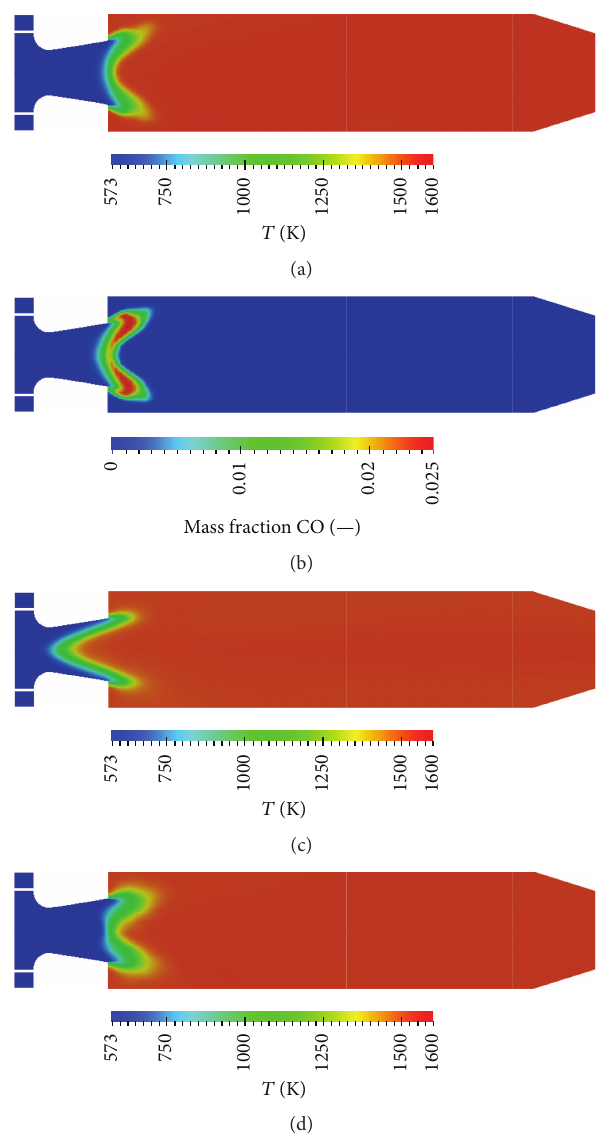
Figure 9: Predicted time-averaged fields of (a) temperature URANS-SST, (b) CO mass fraction URANS-SST, (c) temperature URANS-RSM, and (d) temperature LES, in a plane through com-